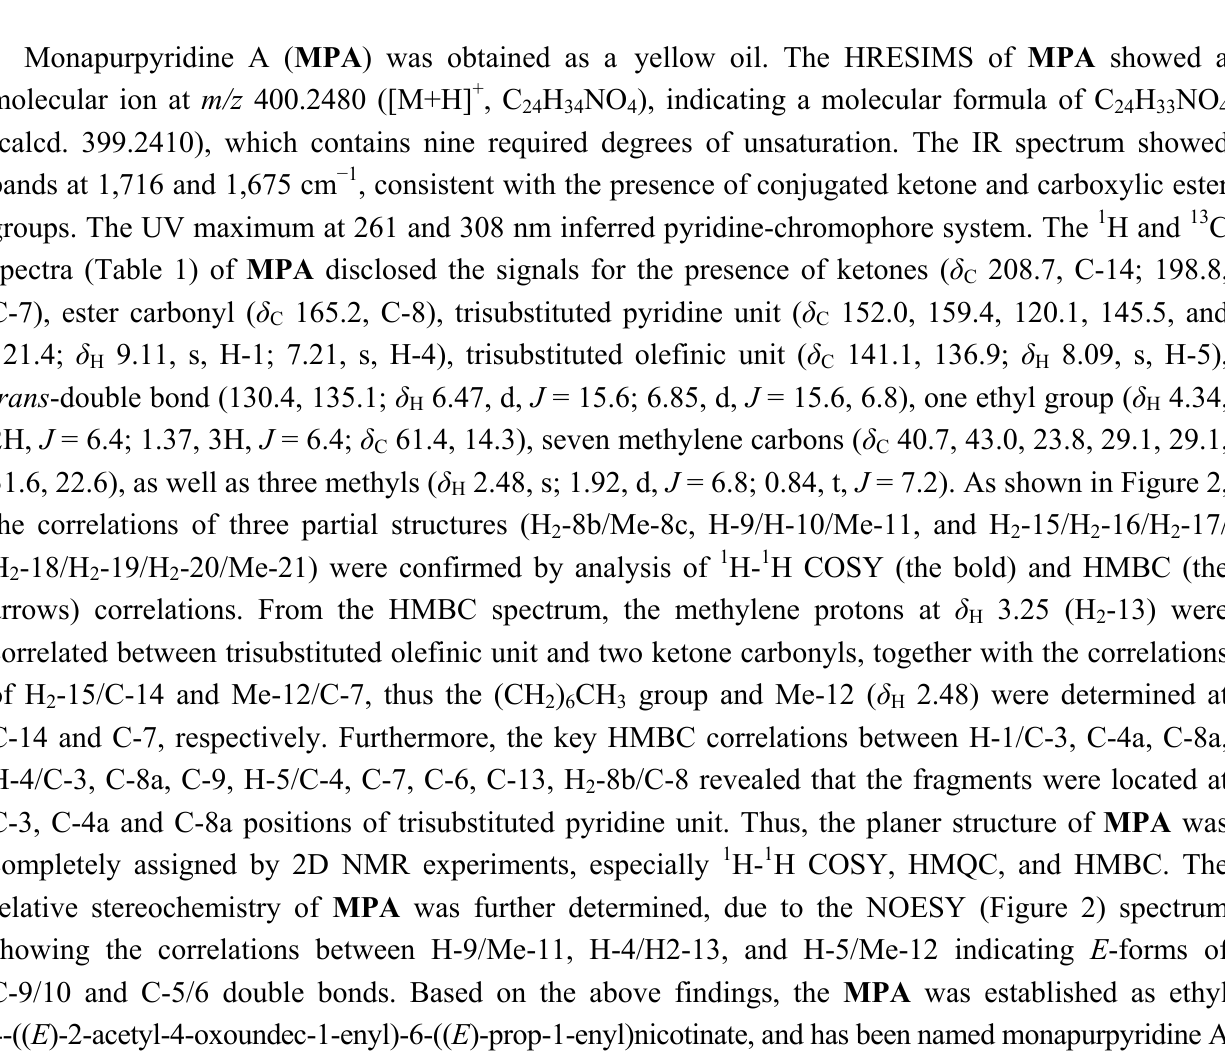
Table 1. 1 H- and 13 C-NMR spectroscopic data of MPA (in CDCl